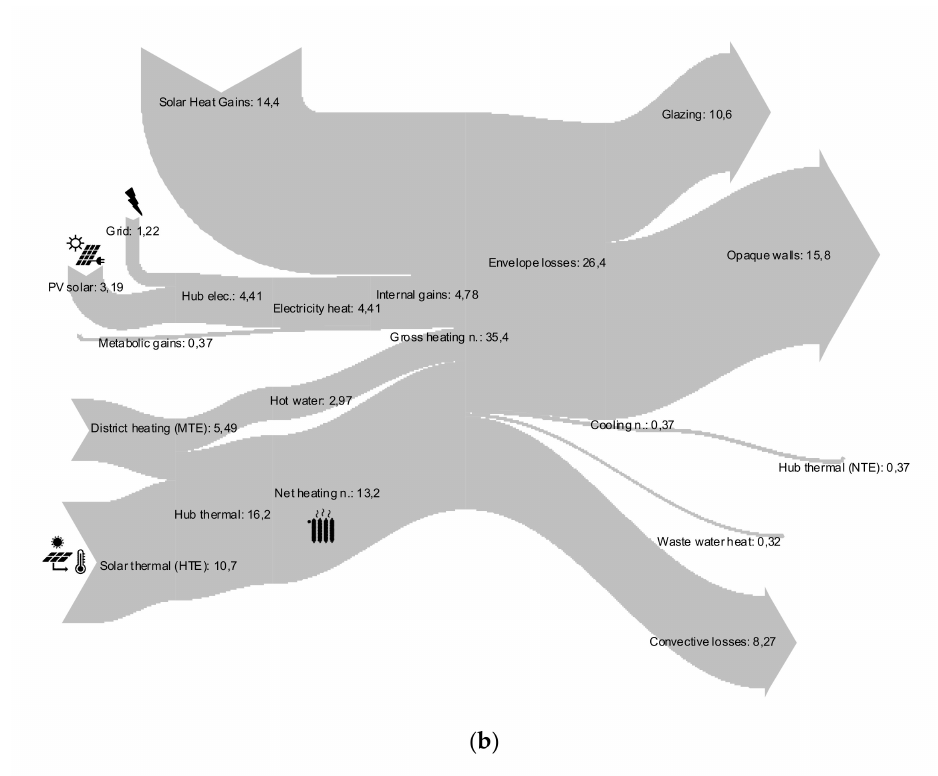
Figure 4. Sankey diagrams of the simulated ( a ) vs. monitored ( b ) scenario for the heating season (kWh/day).